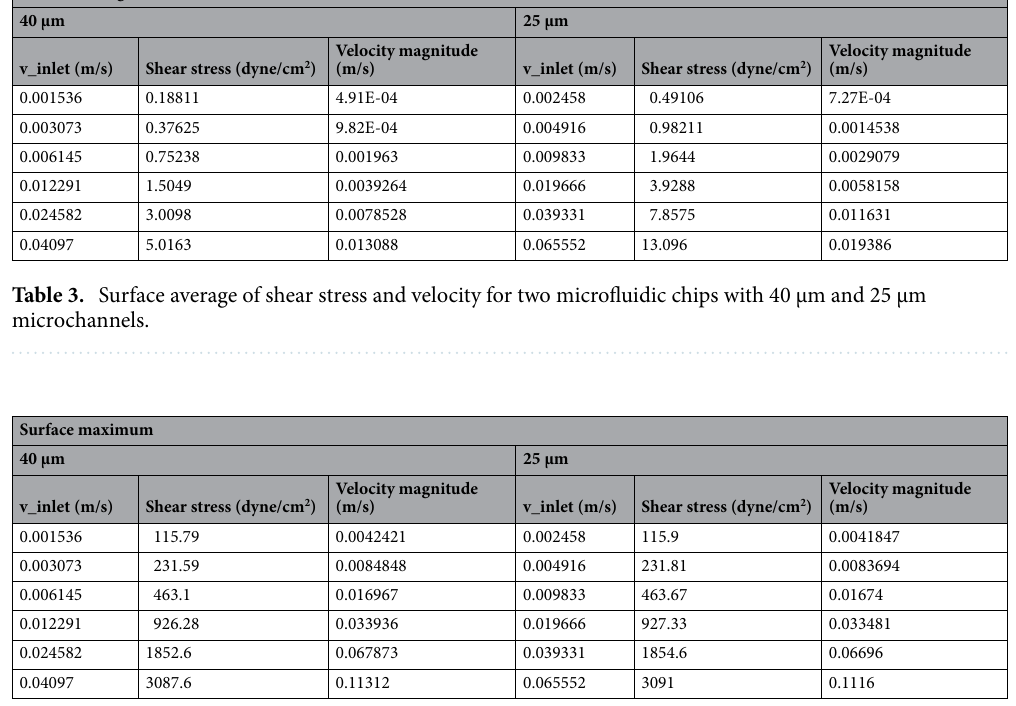
Table 4. Surface maximum of shear stress and velocity for two microfluidic chips with 40 μm and 25 μm microchannels.